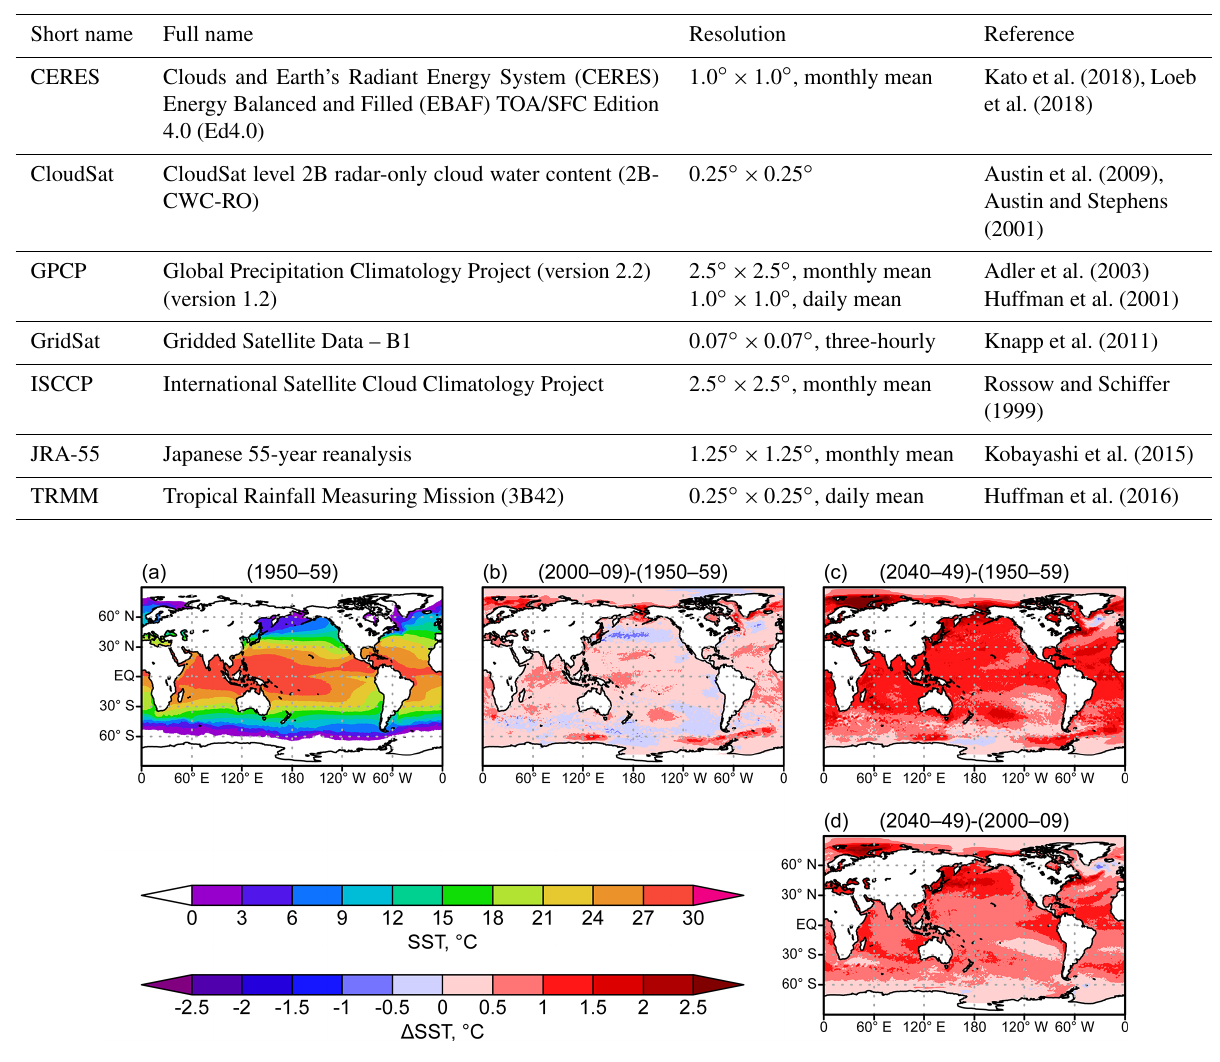
Table 3. List of observational datasets.